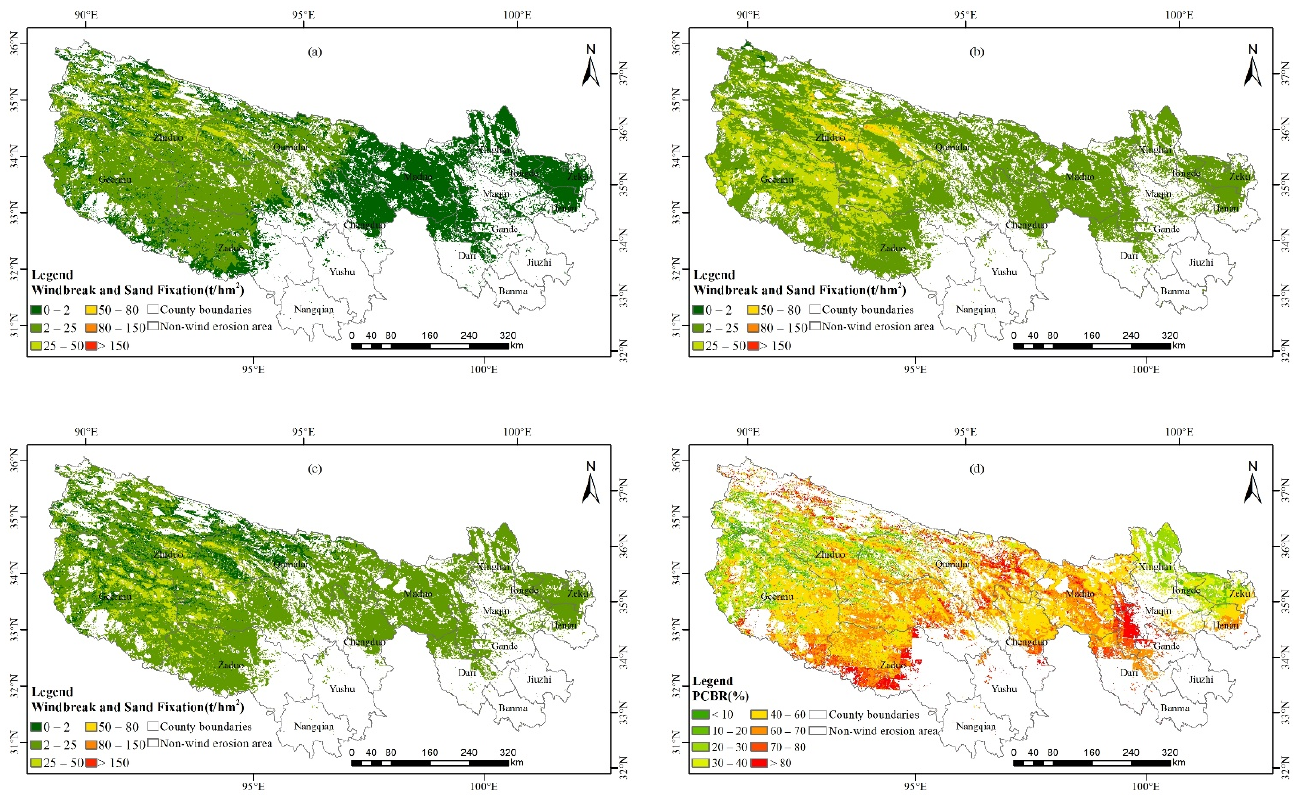
Figure 8. Spatial distribution of average annual windbreak and sand fixation ( a ), change trend ( b ), significant ( c ) and percentage ( d ) of forest and grass ecosystems in the TRHR from 2000 to 2019. The restoration degree of WD service of TRHR ecosystems totaled 345 million t, and the WD per unit area was 13.80 t/hm 2 , which gradually decreased from west to east in space. Most parts of the western region were windy and sandy, and relatively low